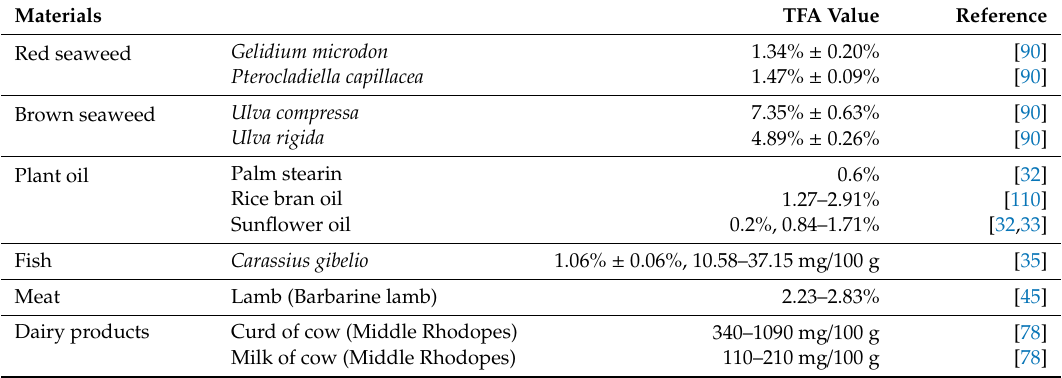
Table 11. Application of TFA in fatty acid evaluation